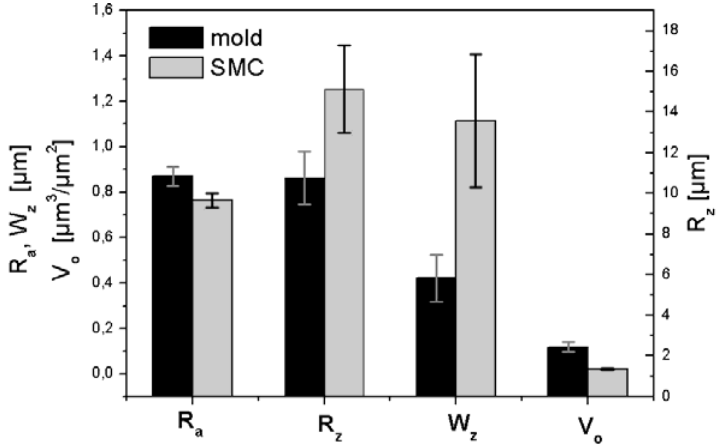
Figure 12. Topographic transfer from metallic mold to SMC